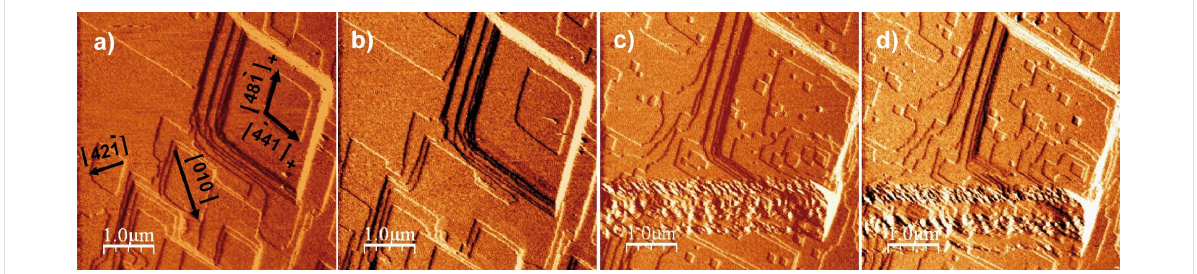
Figure 2: Sequential AFM deflection images of the reacted calcite (104) surface: initially in Millipore MQ water (a and b) and acid solution (pH 4.80) (c and d). Etch pits developed and spread. As pH was decreased to 4.80, a large population of etch pits suddenly formed. Rhombohedra formed along the and directions with the long and short diagonals parallel to [010] and , respectively.